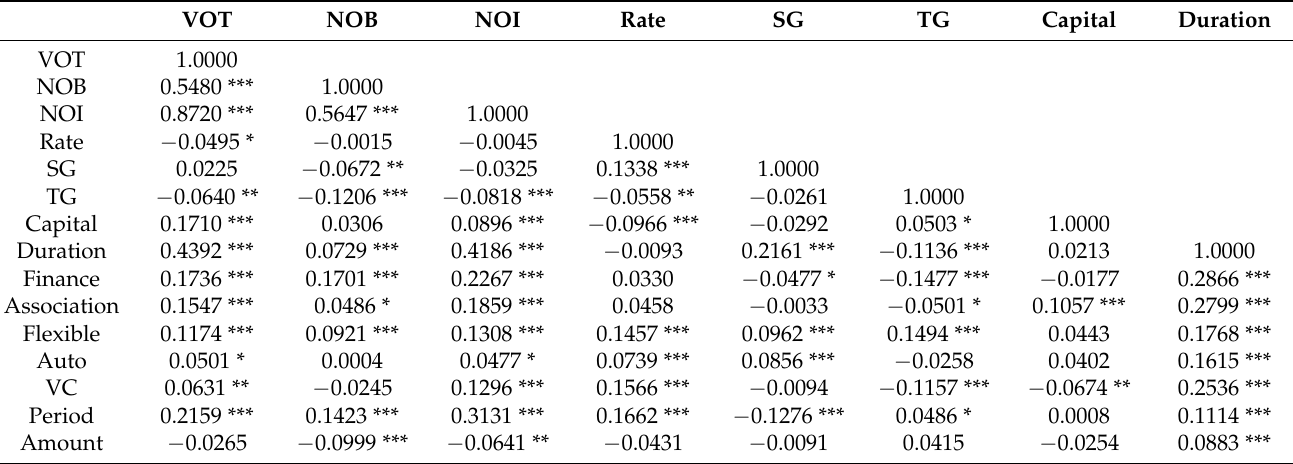
Table 7. Correlation matrix of the